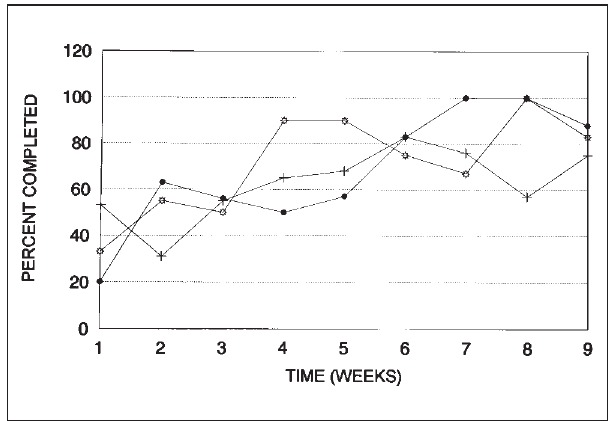
Figure 1) Physicians’ compliance with the perioperative antimicrobial order form. (cid:1) General surgery; + Orthopedics surgery; (cid:2) Urological